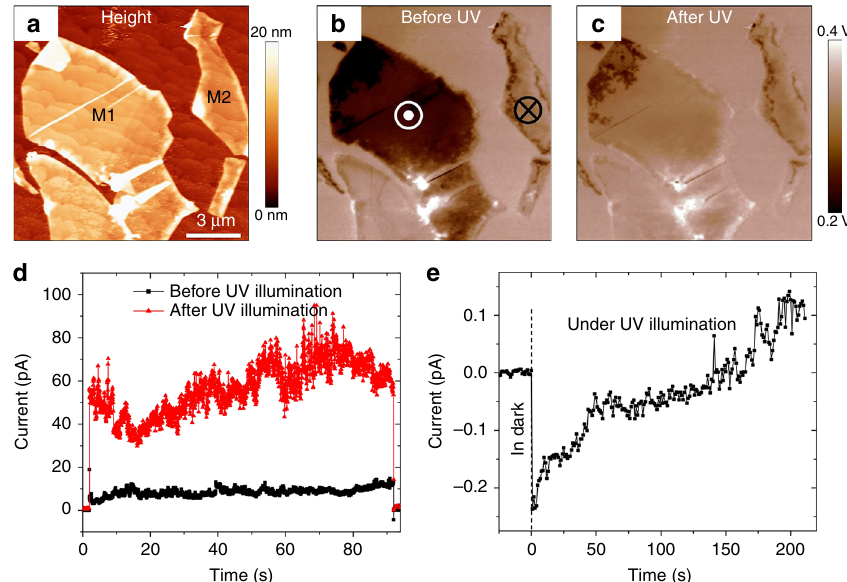
Fig. 3 Optically induced change in surface potential and tunneling current. a AFM topography of the MoS 2 fl akes on the BTO surface. b A surface potential map obtained in the dark after electric poling of BTO under the MoS 2 fl akes (under M1 fl ake – upward, and under M2 fl ake – downward). c A surface potential map of the same fl akes measured in the dark after optical illumination. d Tunneling current measured in the dark before and after illumination, with a DC bias of 0.5 V. e A zero-bias photocurrent measured in the dark and under illumination. In d and e , the initial polarization state of the MoS 2 /BTO/ SRO junction was